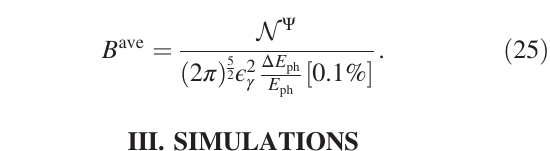
TABLE IV. Interaction parameters XFELO- γ .